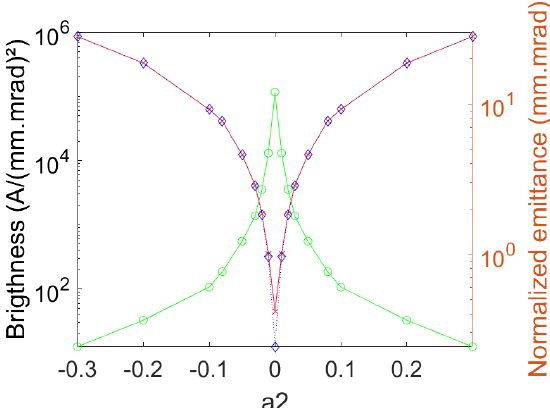
Figure 14. Brightness ( ◦ ) of the electron beam at the center of the undulator versus QUAPEVA 2 a 2 skew term and horizontal ( x ) and vertical ( (cid:5) ) normalized emittance in log scale. Simulation using a “monochromatic” 176 ± 0.1 MeV beam with σ (cid:48) 0.1 ± 0.02 pC, (cid:101) z , i , (cid:101) x , i = 0.2 mm.mrad, transported with the “slit-undulator” optics and the slit in the chicane open to 3.2